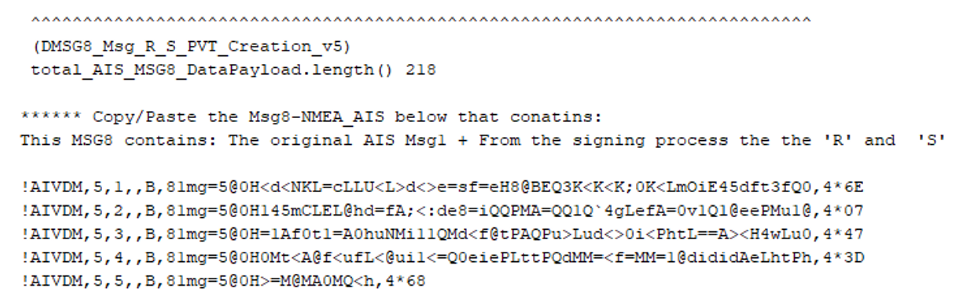
Figure 6. ID8 AIS message that encapsulates the original signed message, the added timestamp, and the variable cryptographic parameters of the signature.